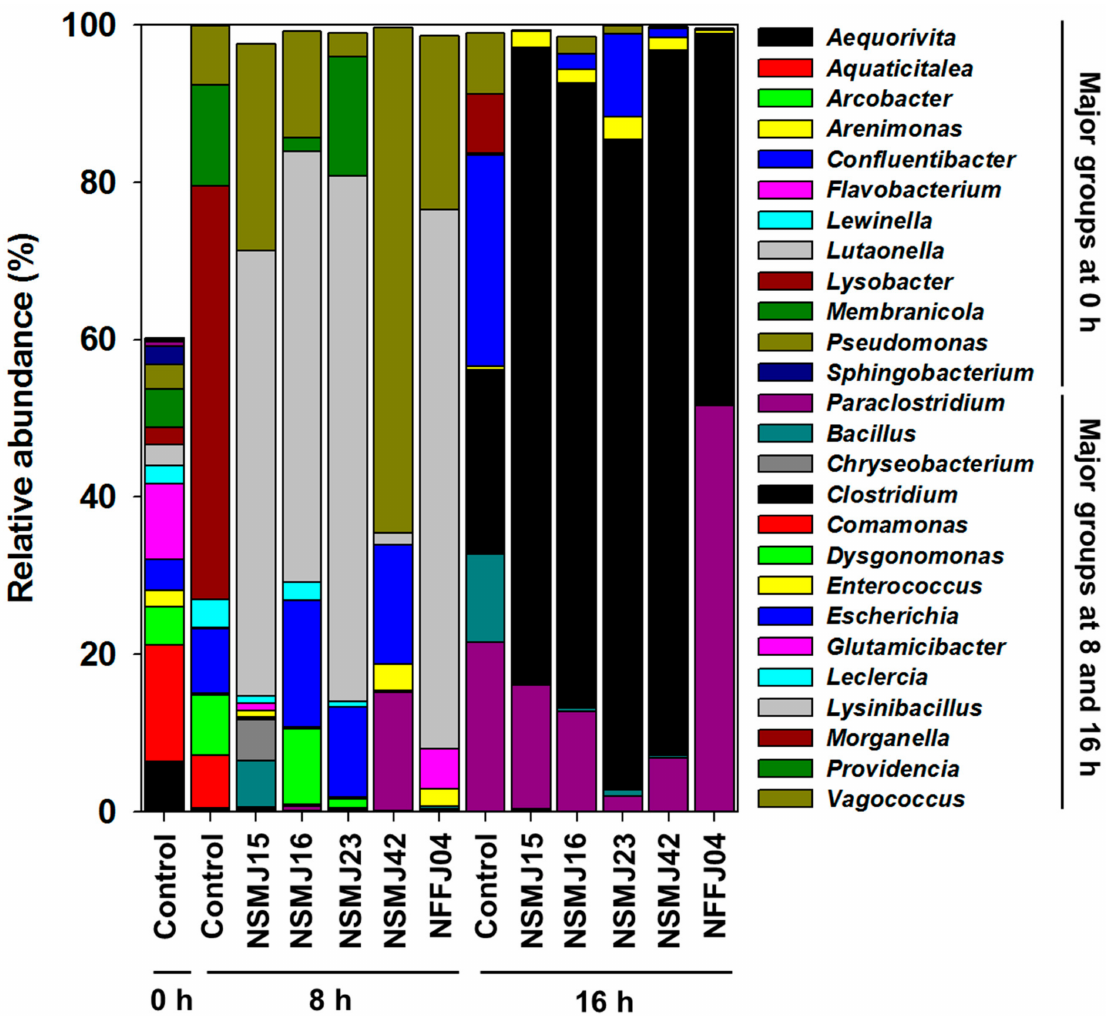
Figure 2. Changes in relative abundance (%) of bacterial taxonomic groups in controls (no treatment) and five CFS-treated samples at the genus level. Genera composed of taxonomic compositions above 2.0% of the total reads in all respective samples are